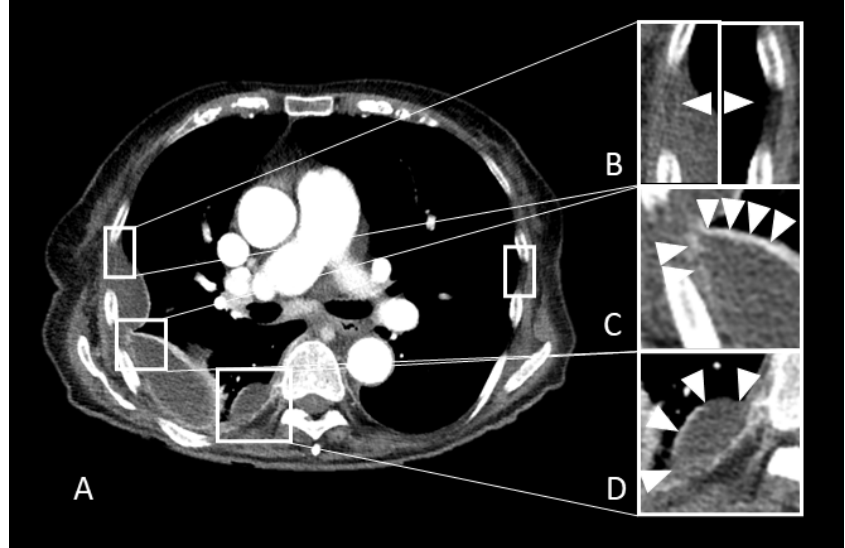
Figure 2. Pathological confirmed pleural empyema of an 83-year-old female patient. ( A ): Original axial slice with empyema on the right side. ( B – D ) Magnifications views with ( B ): Pleural fat thickening and increased attenuation (fat stranding) compared to the contralateral side. ( C ): Pleural thickening with an increased enhancement of the pleura. ( D ): Loculation (biconvex, acute marginal angles).